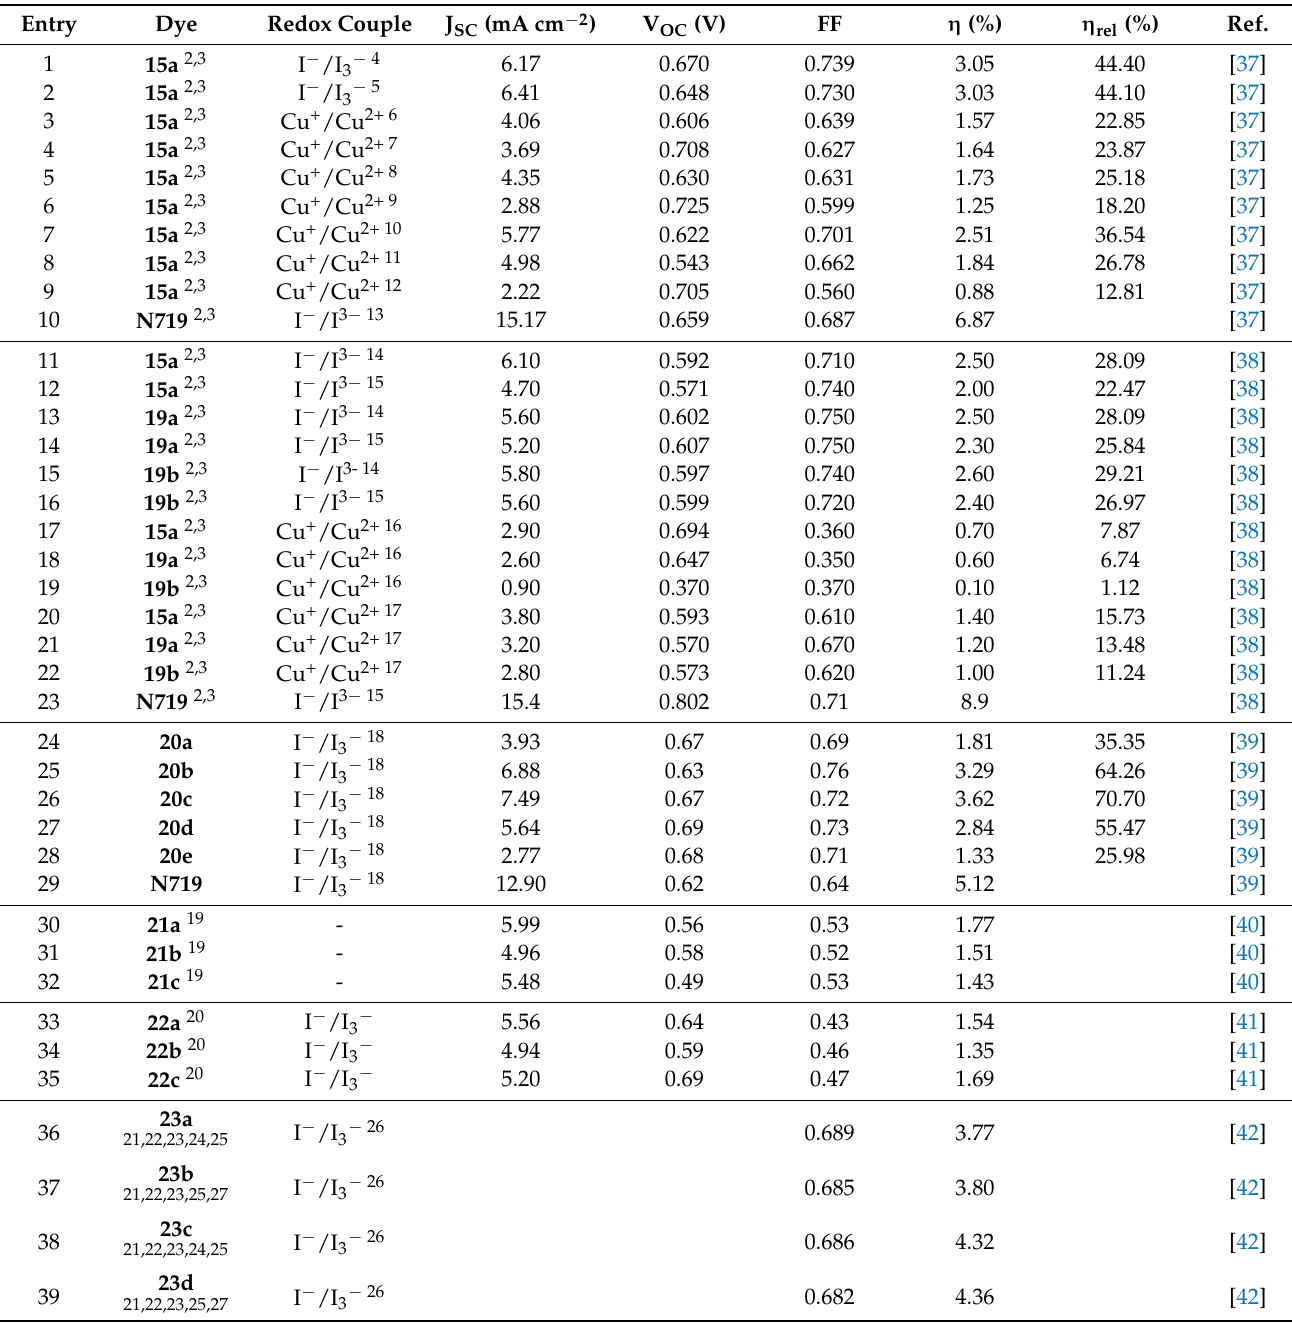
Table 5. Photovoltaic data of DSSCs produced with dyes 15a , 19a – b , 20a – e , 21a – c , 22a – c , 23a – d , 24a – e , and 25a – d 1